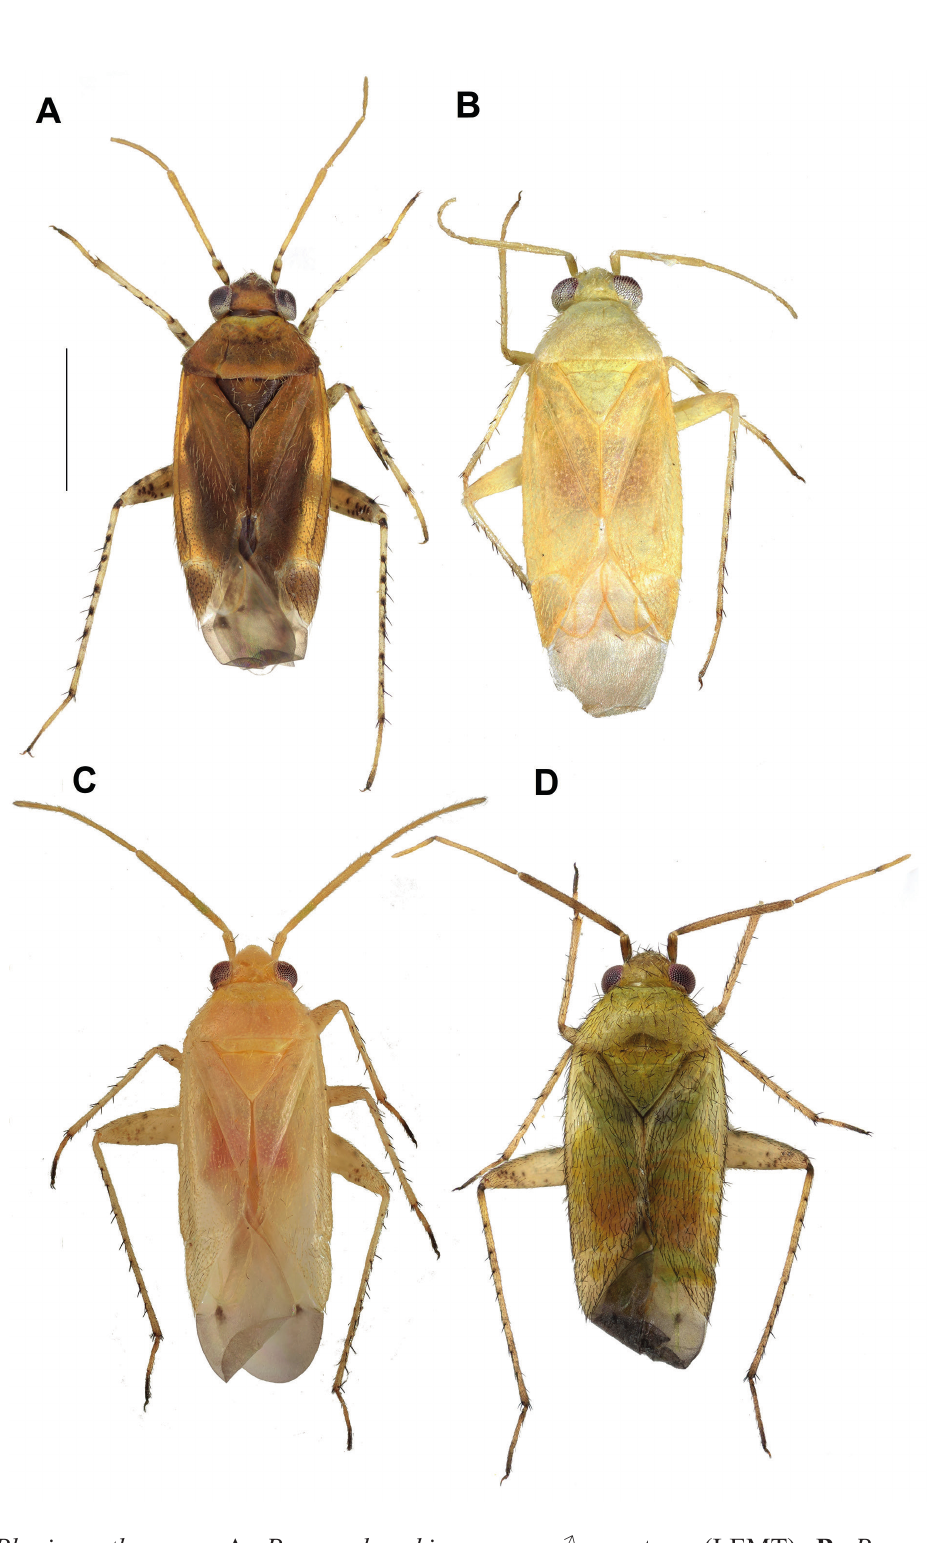
Fig. 4. Plagiognathus spp. A . P. ozgurkocaki sp. nov., ♂, paratype (LEMT). B . P.